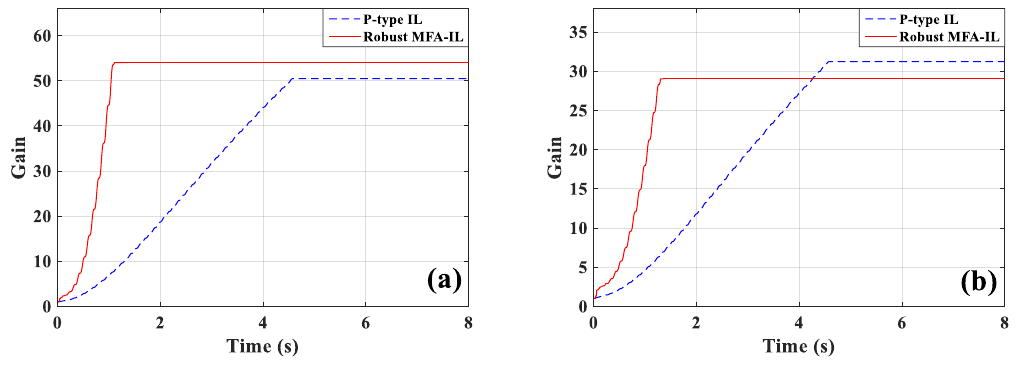
Figure 6. The learning processes of feedback gains: ( a ) Actuator a / b , ( b ) actuator c .